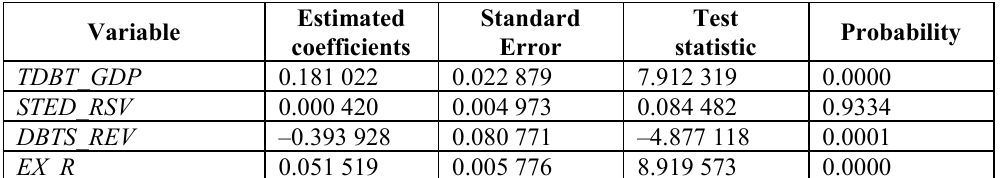
Table 4. Long-Run Estimates (The authors’ computation,